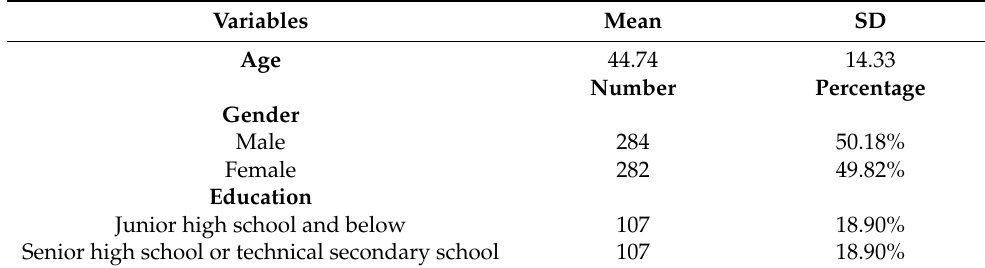
Table 1. Demographic characteristics and the number and percentage of depression and anxiety symptom severity of enrolled tinnitus